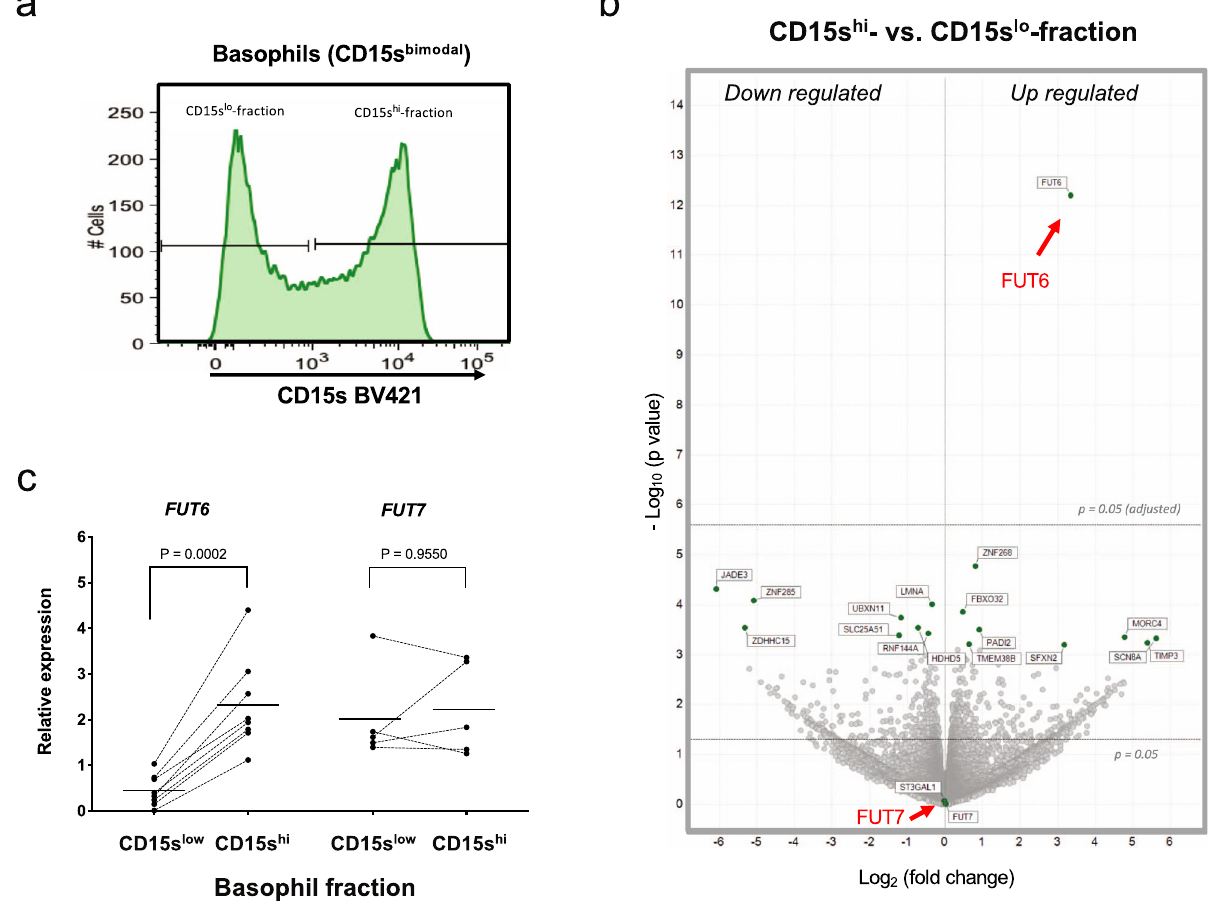
Fig. 3 Gene expression analysis of CD15s high and CD15s low basophils. a FACS sorting of CD15s high and CD15s low fraction of CD15s bimodal individuals. FACS pro fi le and sorting gates of the CD15s low and CD15s high basophil fraction are shown for one representative donor from six donors. b Volcano plot. The plot summarized the edgeR paired RNA-seq results of the pairs of CD15s high vs. CD15s low fractions obtained from six CD15s bimodal donors. Each dot represents a gene and the plot displays the fold change (log2) vs. nominal p value ( − log10). Boundaries for nominal and adjusted p value are indicated. c Validation by qPCR. The mRNA expression of FUT6 (n = 8) and FUT7 ( n = 6) in the CD15s low and CD15s high fraction validated by qPCR. Paired samples are connected by lines; p values are indicated. Statistical comparison was performed using Wilcoxon matched-pairs signed-rank